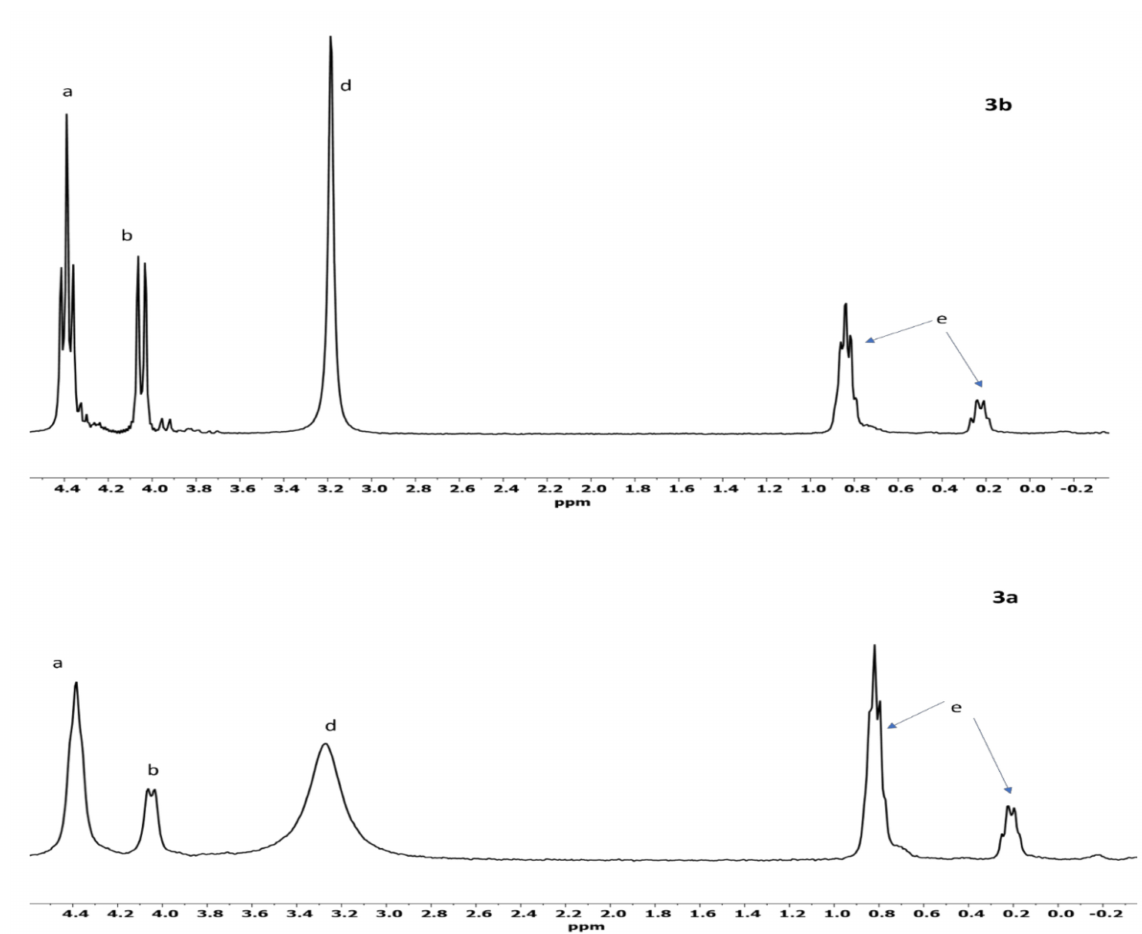
Figure 3. Comparable spectra of GP formation in the presence of serpentine as a catalyst. The unspiked spectrum ( a ) and same reaction spiked with standard GP ( b ).